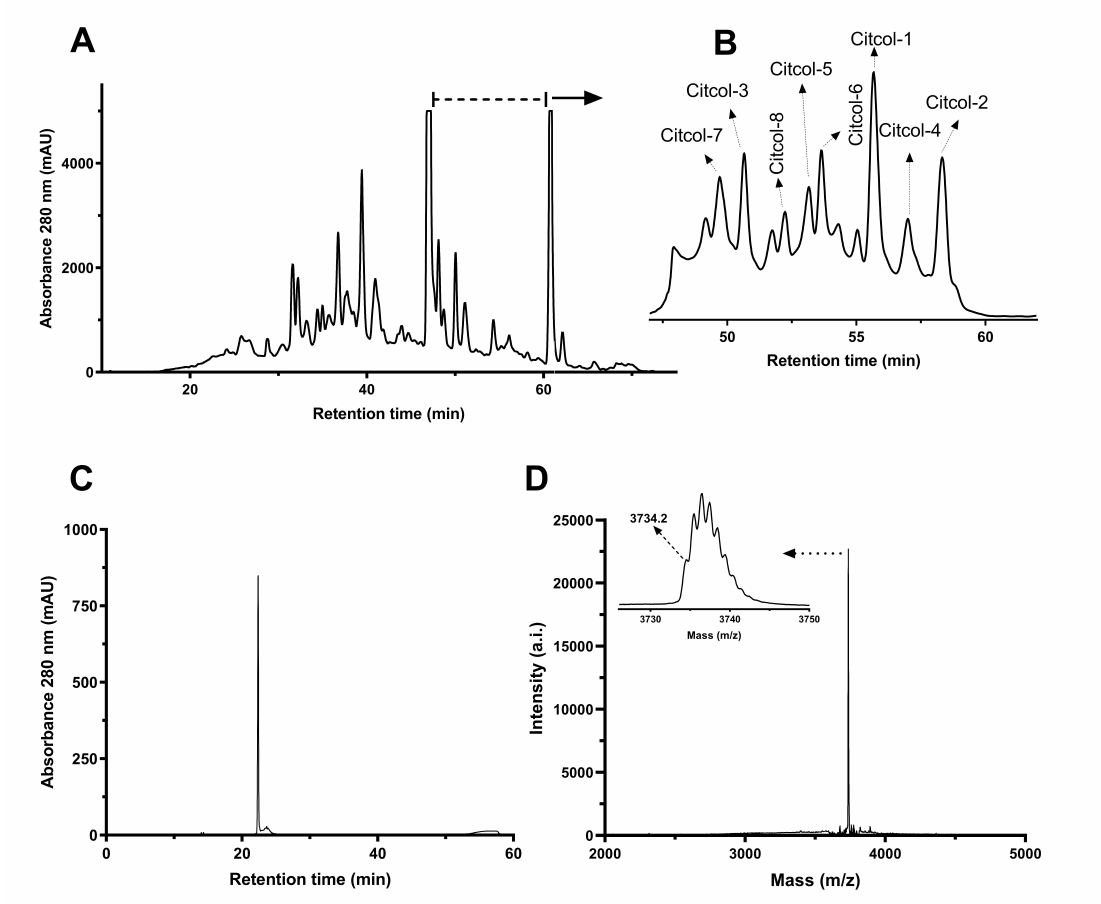
Figure 2. Fractionation and purification of cysteine-rich citcol peptides by reversed-phase HPLC. ( A ) Purification chromatogram by preparative RP-HPLC; the dashed line indicates the elution region of citcol peptides. ( B ) Semi-preparative RP-HPLC of the elution region of citcol peptides (retention time 47-60 min) indicating peaks for citcol-1 to -8. ( C ) Analytical RP-HPLC chromatogram of citcol-2 (purity ~95%). ( D ) Molecular weight analysis of citcol-2 corresponding to a monoisotopic mass [M + H] + of 3734.1 Da. For HPLC analysis linear gradients of solvent C (90% acetonitrile, 9.92% H 2 O and 0.08% TFA) were used at flow rates of 8, 3 and 0.3 mL / min for preparative, semi-preparative and analytical RP-HPLC,